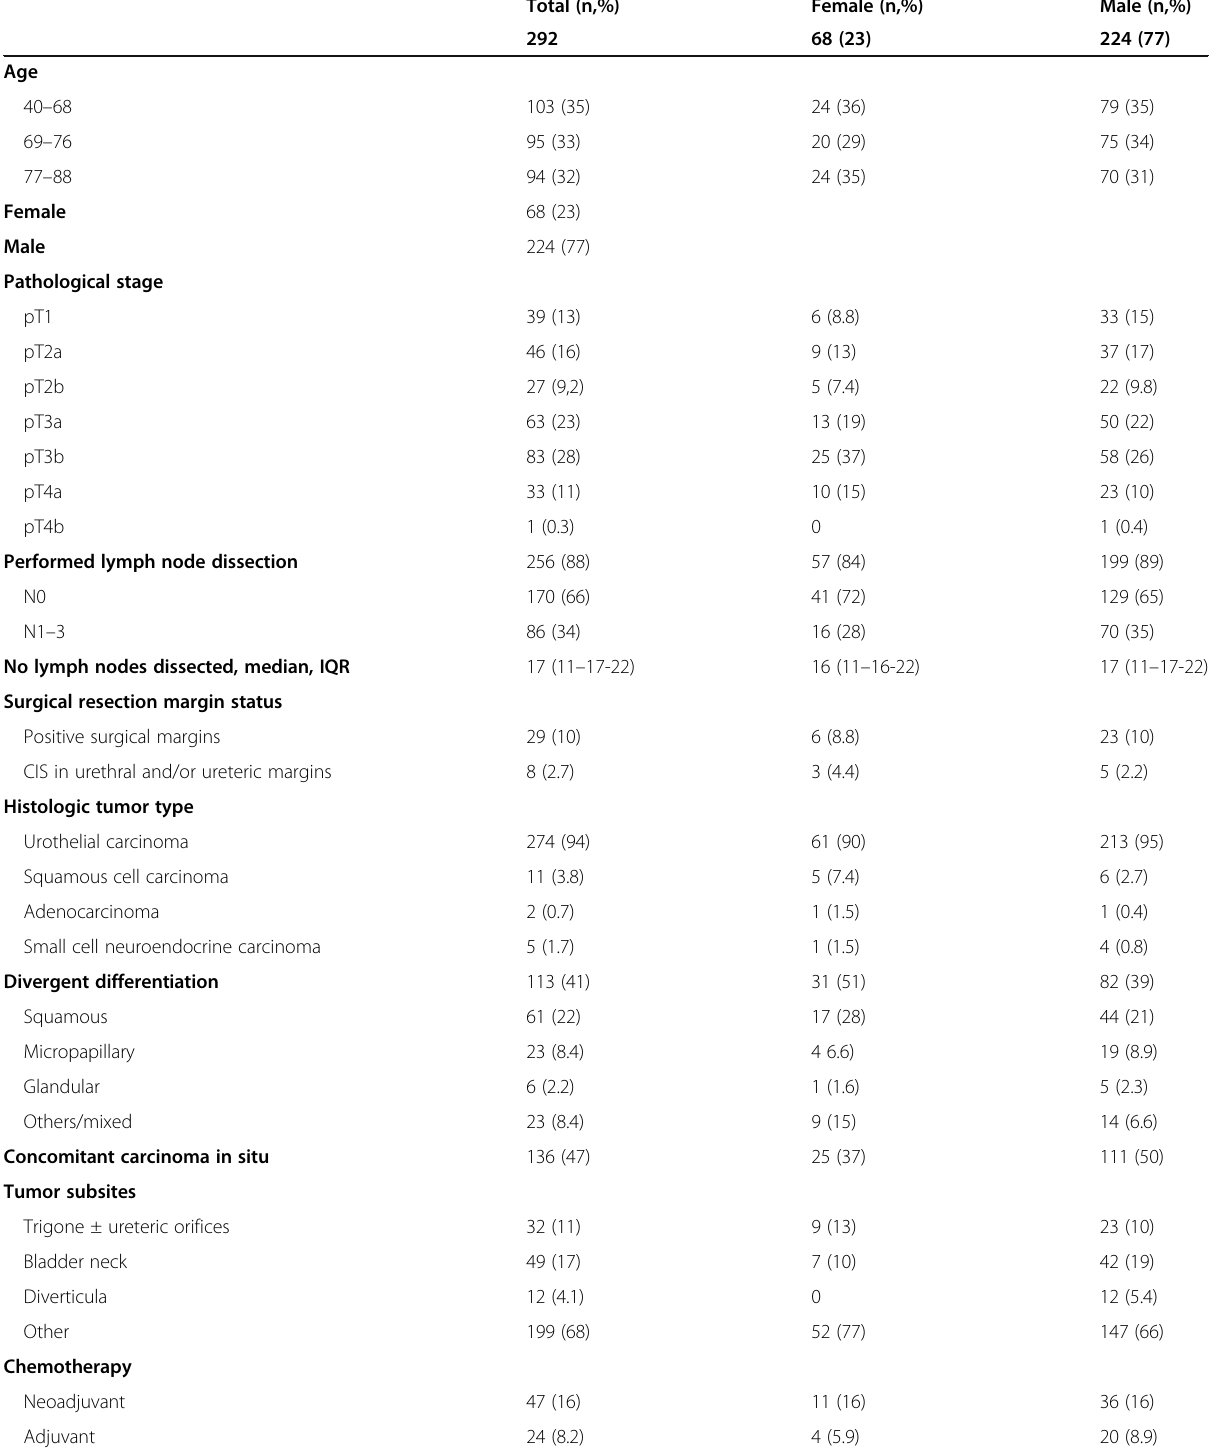
Table 1 Patient characteristics for the study cohort, in total and stratified by